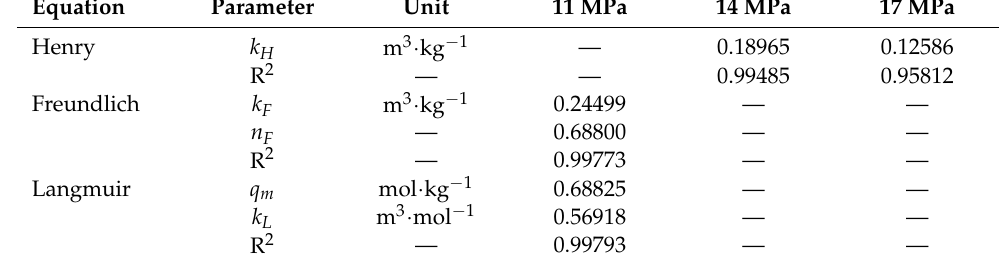
Figure A2. Uptake of RuCp 2 on AC at 333 K and different pressures; experimental data taken from [64]. Table A2. Adsorption isotherm parameters for RuCp 2 on AC from scCO 2 solution at 333 K and different pressures [64].